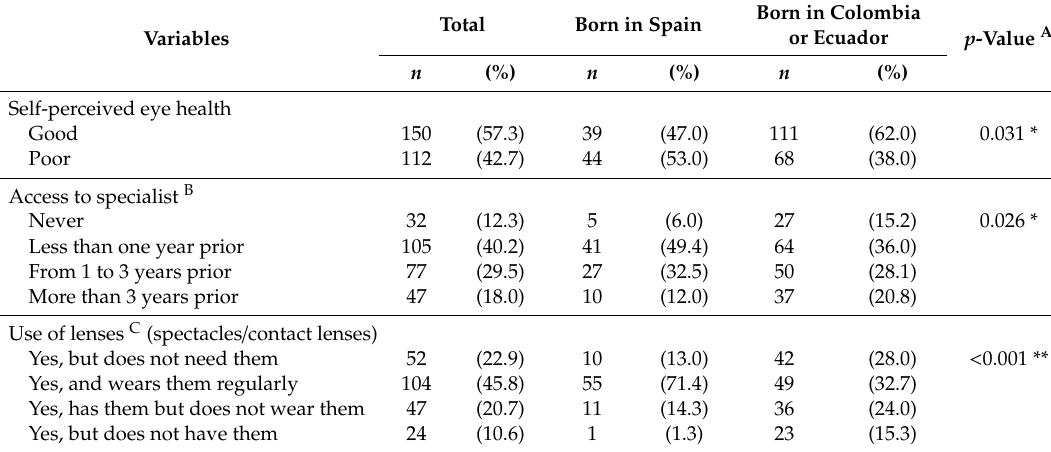
Table 2. Prevalenceofself-perceivedeyehealth,accesstoaspecialist(ophthalmologist / optician-optometrist), and use of lenses (spectacles / contact lenses) in workers included in the study by sociodemographic and occupational